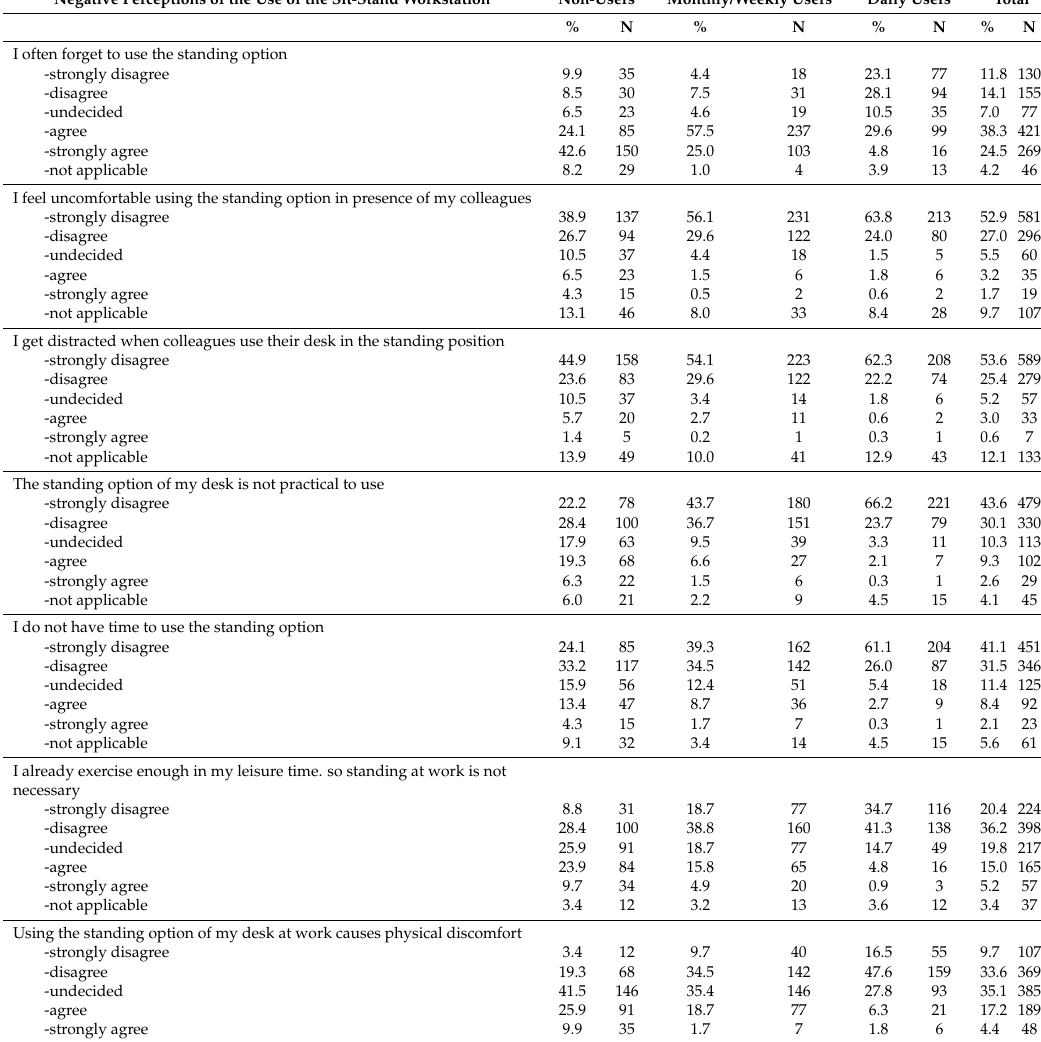
Table A6. Agreement with perceived negative perceptions of the use of the sit-stand